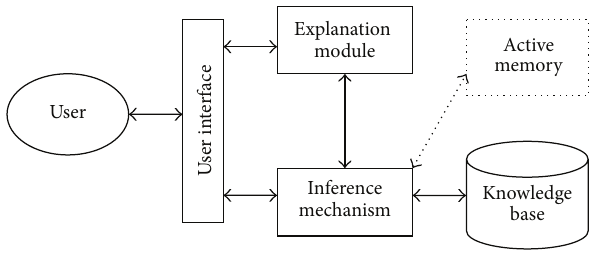
Figure 1: The main structure of decision support